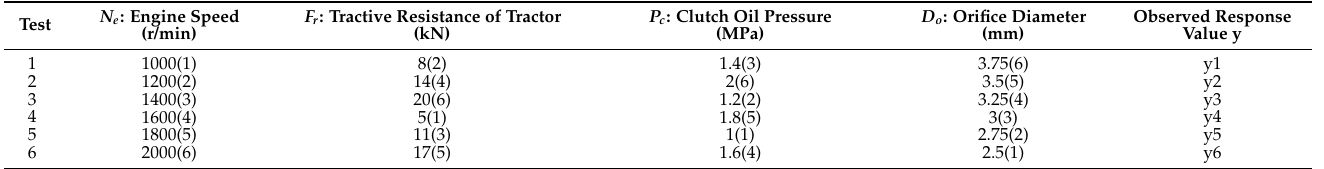
(cid:0) (cid:1) 6 4 . 6